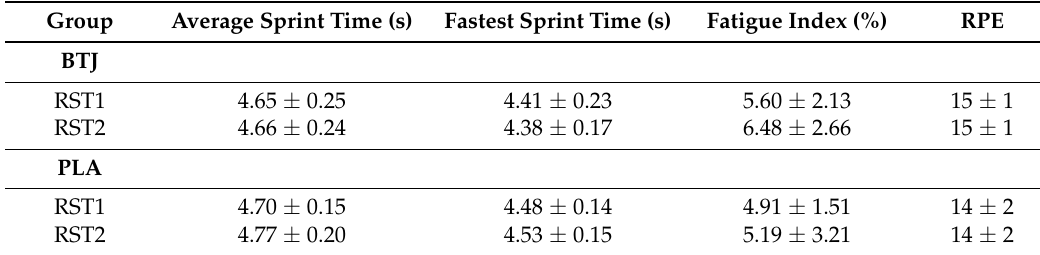
Table 4. Sprint and RPE data for the beetroot juice (BTJ) and placebo (PLA) groups in the first and second repeated sprint tests (RST1 and RST2,